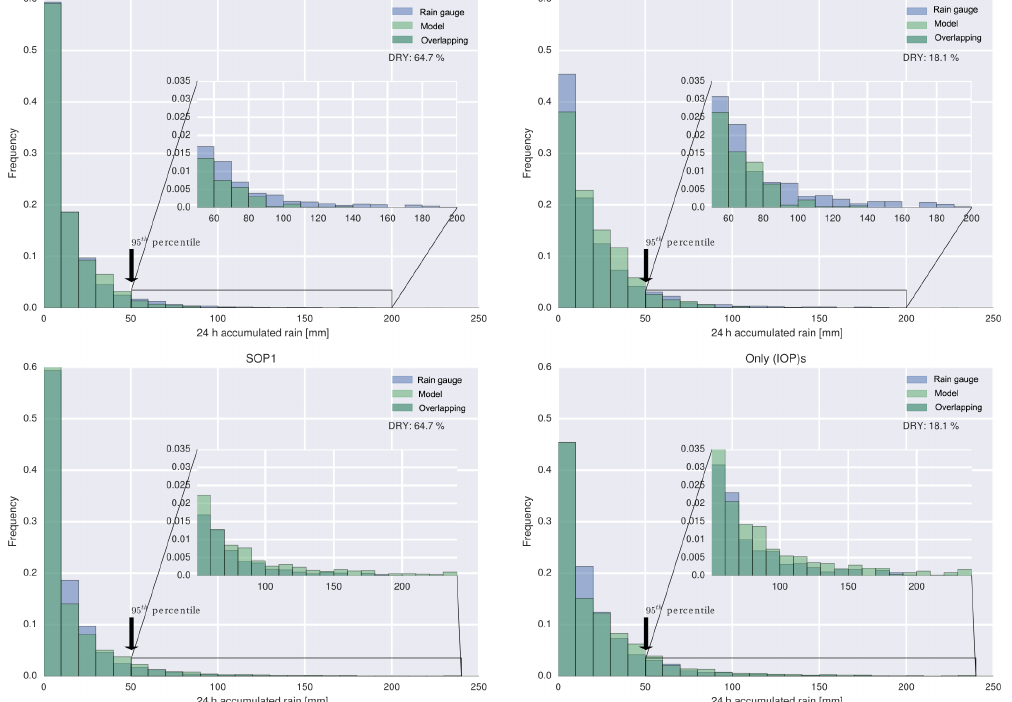
Figure 10. Normalized histogram of rain events (24h accumulated precipitation on rain gauge station greater or equal 0.2mm/24h) for the entire SOP1 period (5 September to 6 November 2012) (left column) and for days of selected IOPs within the same period (right column). The first histogram bin starts from 0.2mm, whereas the number of dry days for a given period is indicated on the graph. The location of the 95th percentile of the SOP1 rain events distribution (50.42mm/24h) is shown. The area of the histogram after the 95th percentile is enlarged and shown as an inset to improve readability. The frequency of the precipitation events for rain gauge is coloured in blue and in light green for the model, whereas dark green indicates the overlapping of the model and rain gauge data. First row: ALADIN 8km. Second row: ALADIN 2km upscaled to an ALADIN 8km